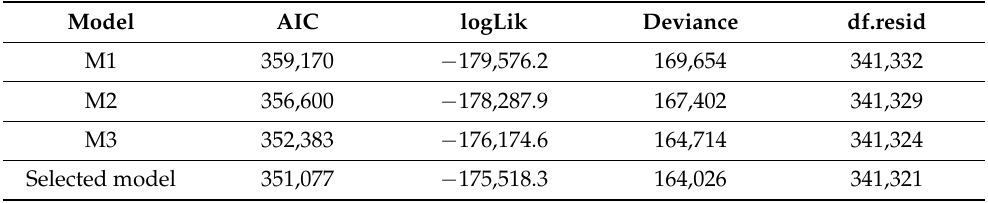
Table 1. Accuracy assessment of the best-performing models. Goodness-of-fit measures: AIC (Akaike information criterion), logLik (log-likelihood function), deviance (residual deviance), and df.resid (degrees of freedom—residual). M1 includes annual precipitation, annual maximum temperature, and summer precipitation; M2 adds to M1 the squared and logarithmic transformations of its variables; M3 adds on to M2 the interactions between each one. The selected model adds spring precipitation to